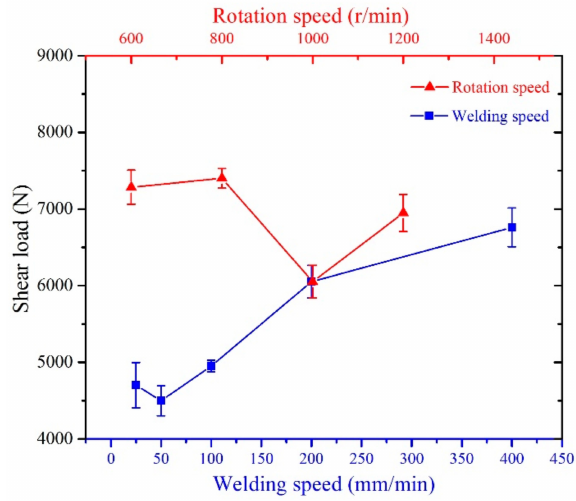
Figure 17. The variation of shear load with different welding